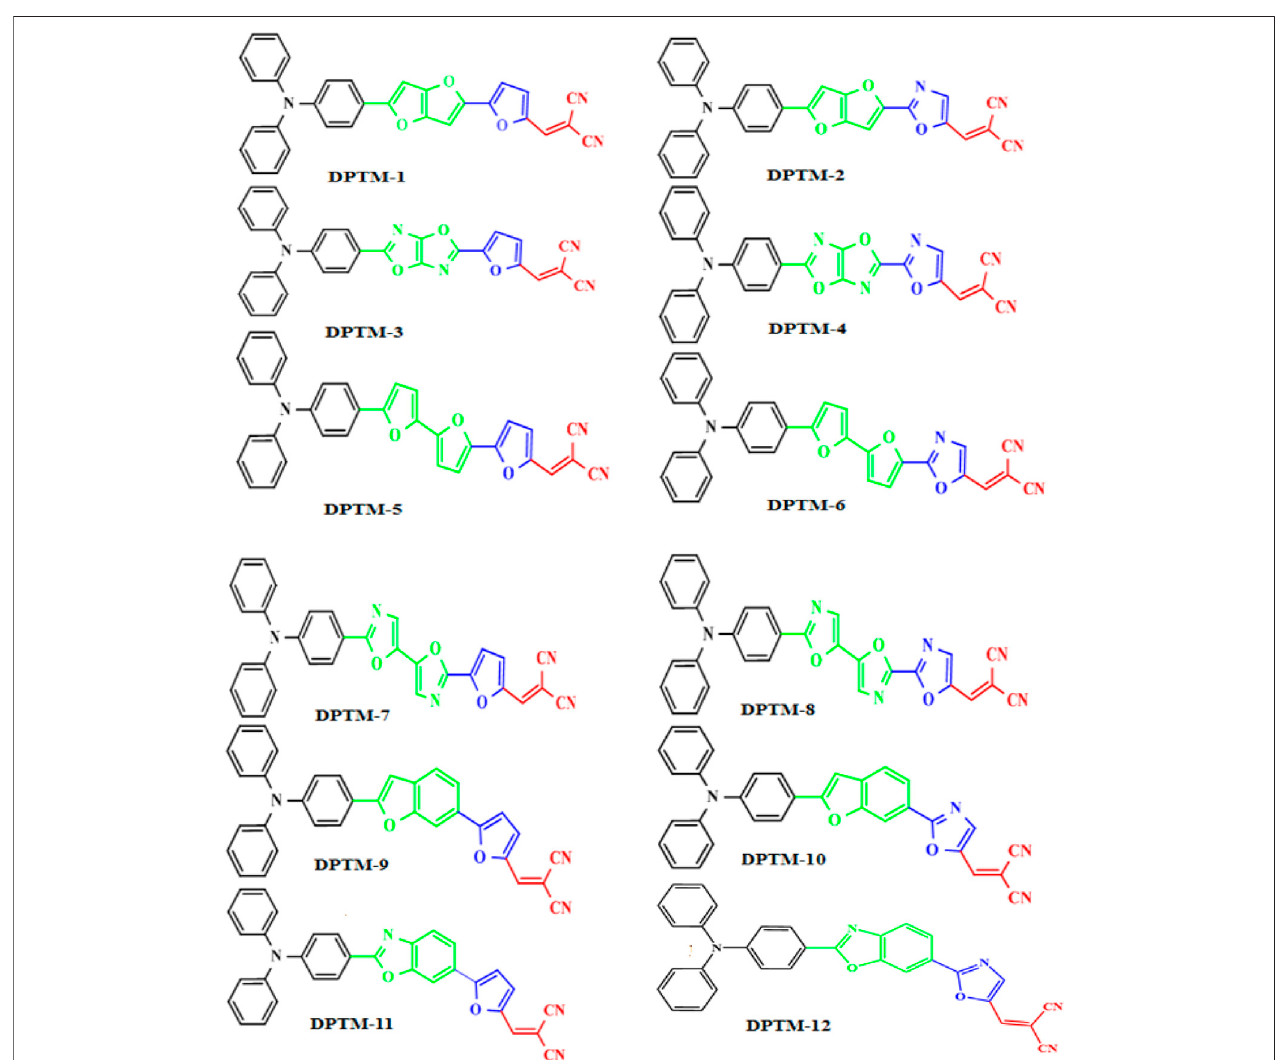
FIGURE 1 | Structures of the investigated compounds (DPTM-1 to